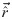
Model manifold with boundary.(A) The tangent at the optimum is perpendicular to its residual vector r^→. Boundaries of the model manifold, shown in orange, are marked by black segments. In the parameterization by the model parameter θ the boundaries are reached in the limit θ → ±∞. (B) The values of χ2 on the interval [−∞, ∞] are shown as graph, illustrating the boundedness of the function.